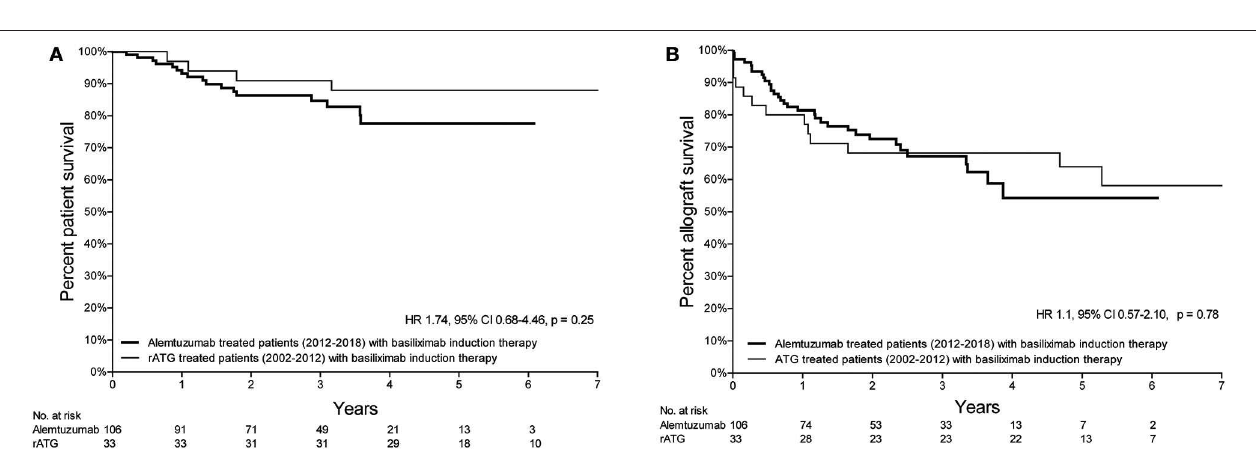
FIGURE 2 | Kaplan-Meier survival curves of the patient- and allograft survival of patients treated with basiliximab induction therapy. (A) Kaplan-Meier curve of the patient survival curve (from the time of treatment) of patients treated with either alemtuzumab (2012–2018) or rATG (2002–2012) for AR and who received induction therapy with basiliximab. (B) Kaplan-Meier curve of the allograft survival curve (from the time of treatment) of patients treated with either alemtuzumab (2012–2018) or rATG (2002–2012) for AR and who received induction therapy with basiliximab.